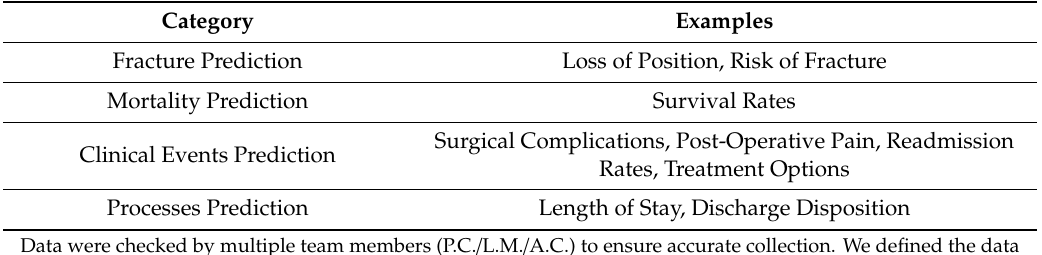
Table 3. Types of Tool Output